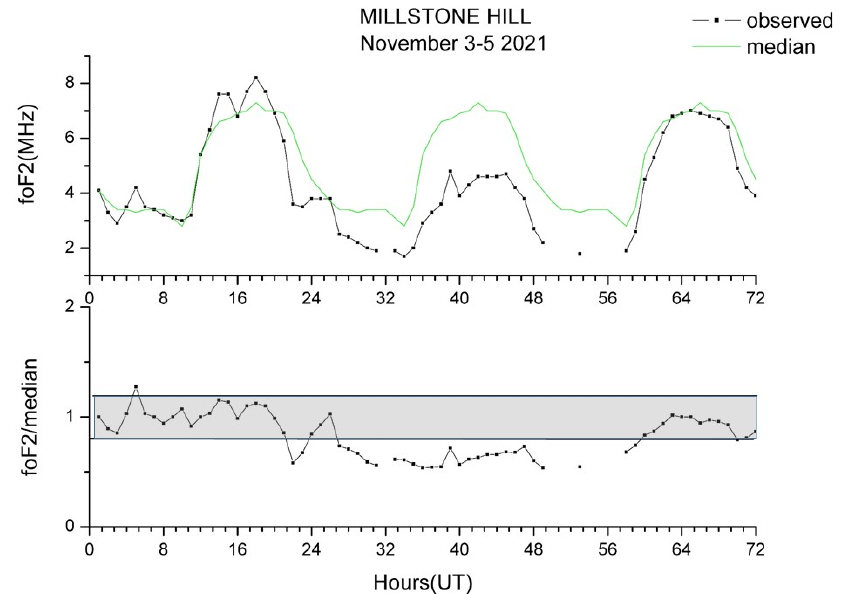
Figure 7. foF2 observations at Millstone Hill in the American sector, during 3–5 November 2021. Upper panel: Observed hourly (black line) and median values evaluated in the 27 days preceding 3 November 2021 (green line) foF2 variations; bottom panel: foF2/median variation (black line), for the 3–5 November 2021 geomagnetic storm. Grey shaded area indicates the [0.8; 1.2] variability range during quiet